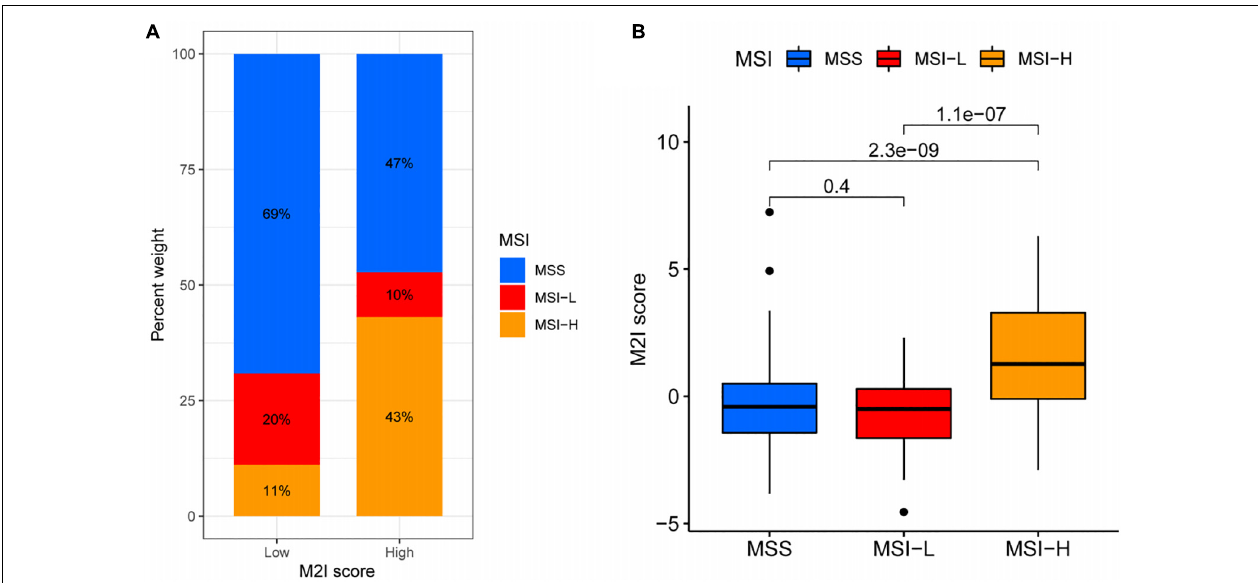
FIGURE 6 | Relationship between M2I score and MSI. (A) The proportion of different MSI levels in the subgroups with high and low M2I scores. (B) Differences in M2I scores among groups with different MSI